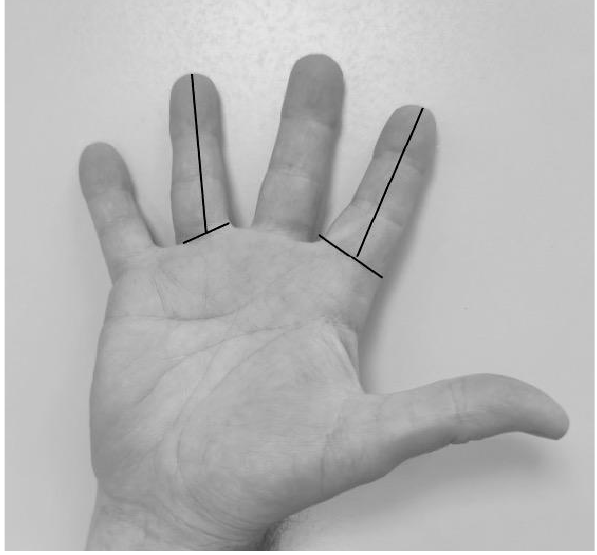
Figure 1. Measurement of 2D and 4D fingers in a healthy male volunteer.